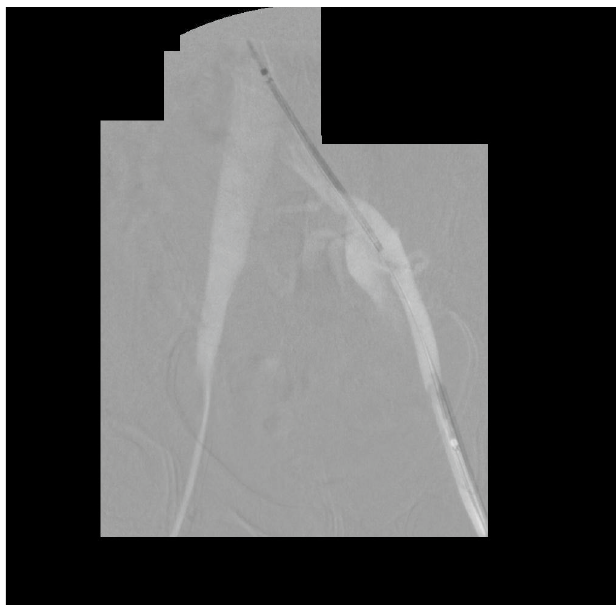
Fig. 1. Selected frame of a subtracted venogram with self-expanding metallic stent across the left common iliac vein stenosis pre-deployment.